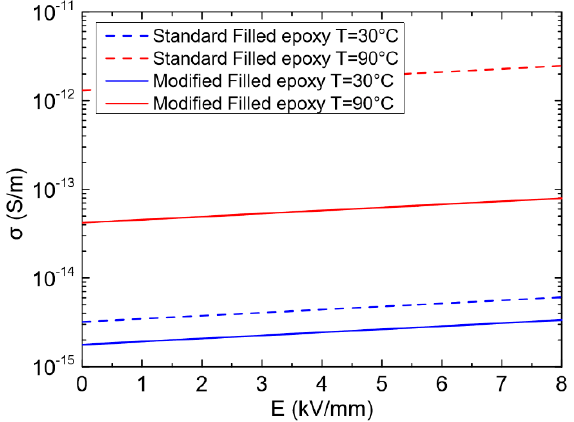
Figure 3. Plot of the conductivity of the modified filled epoxy material (W a = 0.5 eV) and conventional alumina-filled epoxy (W a = 0.95 eV).